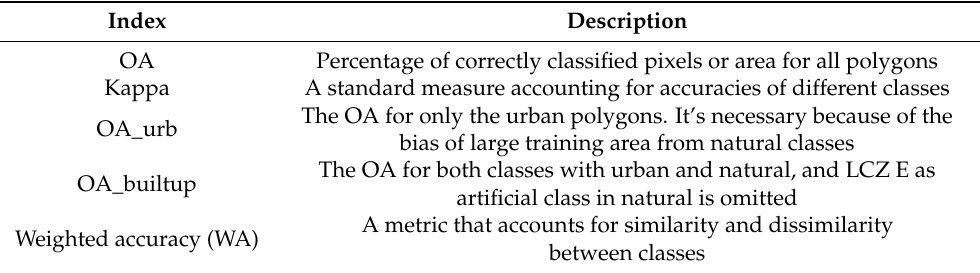
Table 1. Five accuracy measures for LCZ classification